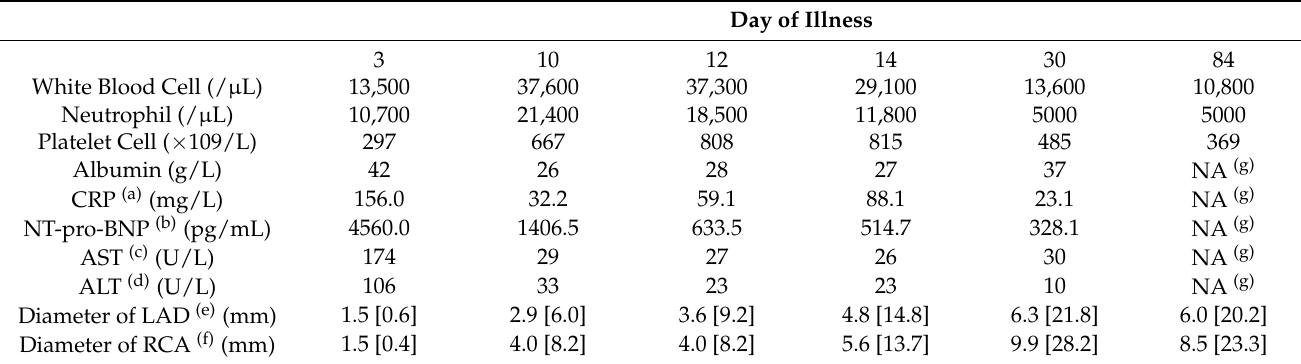
Table 1. Laboratory and Echocardiogram Data in the Clinical